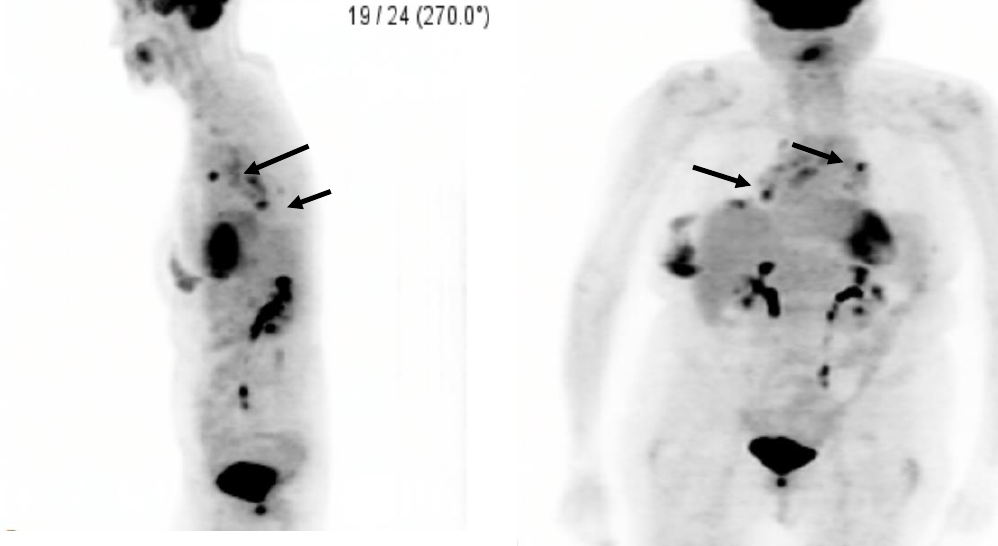
Figure 2. PET/CT demonstrating increased uptake with multiple mediastinal lymph nodes with a nodule in the right middle lobe and a spiculated left lung nodule with concern for breast involvement: the black arrows point to areas of suspicion.